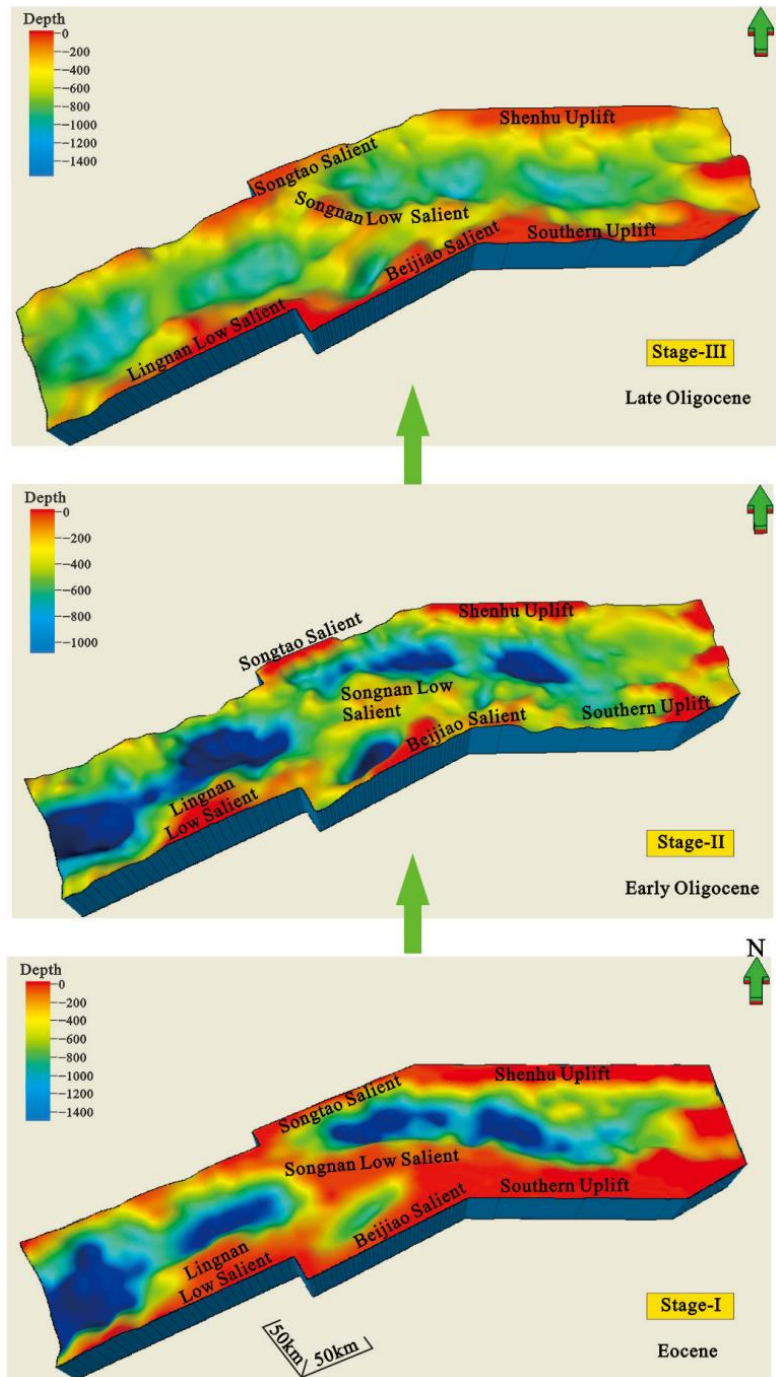
Figure 7. The ancient landform of every tectonic phase in the deep-water area of the Paleogene QDN Basin. In Phase-I, at the basin margin, several subsidence centers developed and then moved backwards to the basin boundary in Phase-II. During Phase-III, the subsidence centers migrated to the central basin.